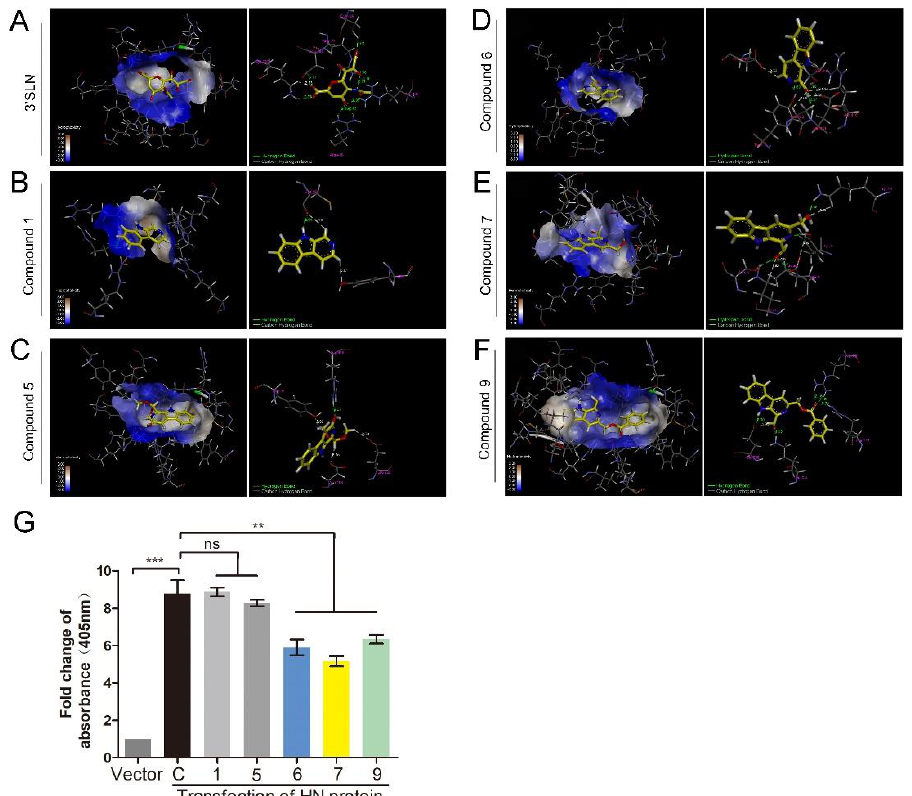
Figure 4. 1-formyl- β -carboline derivatives interact with the HN protein. ( A – F ) Docking results of 3 ′ SLN ( A ), compounds 1 ( B ), 5 ( C ), 6 ( D ), 7 ( E ), and 9 ( F ) in the binding site of the HN protein. Hydrogen bonds are shown as dotted lines, with a distance unit of Å . ( G ) BHK-21 cells were transfected with HN or vector. At 24 h post-transfection, cells were washed and incubated with a 1% suspension of red blood cells (RBCs), supplemented with or without each compound (20 μM), at 4 °C for 1 h. Next, the absorbance was measured at 405 nm. The statistical significance was analyzed using a two-tailed Student ’ s t -test: ns (not significant); ** p < 0.01; *** p < 0.001.